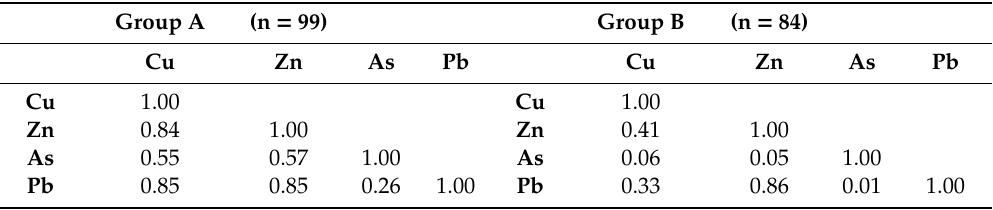
Table 3. Coe ffi cient (r) between concentrations of heavy metal elements in soil